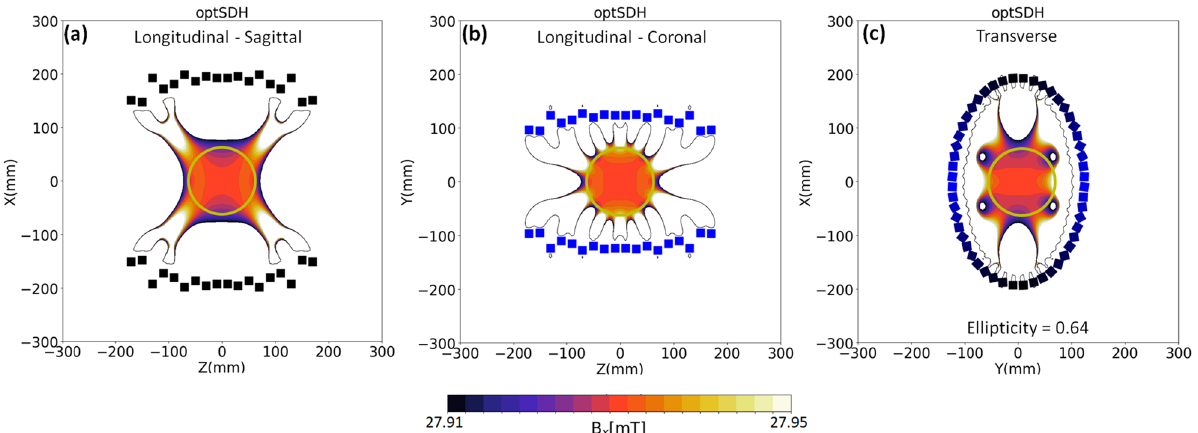
Figure 5. Design of an elliptical magnet ( ε = 0.64 ) with a length equal to its diameter, and variable diameter rings: 2D contour plots showing the magnetic field profile in the ( a ) sagittal, ( b ) coronal and ( c ) transverse directions. The colour bar is the same for the three field contour plots. The magnets are coloured from black to blue from the semi-major to the semi-minor axis. A spherical ROI is depicted by the solid circle in the three